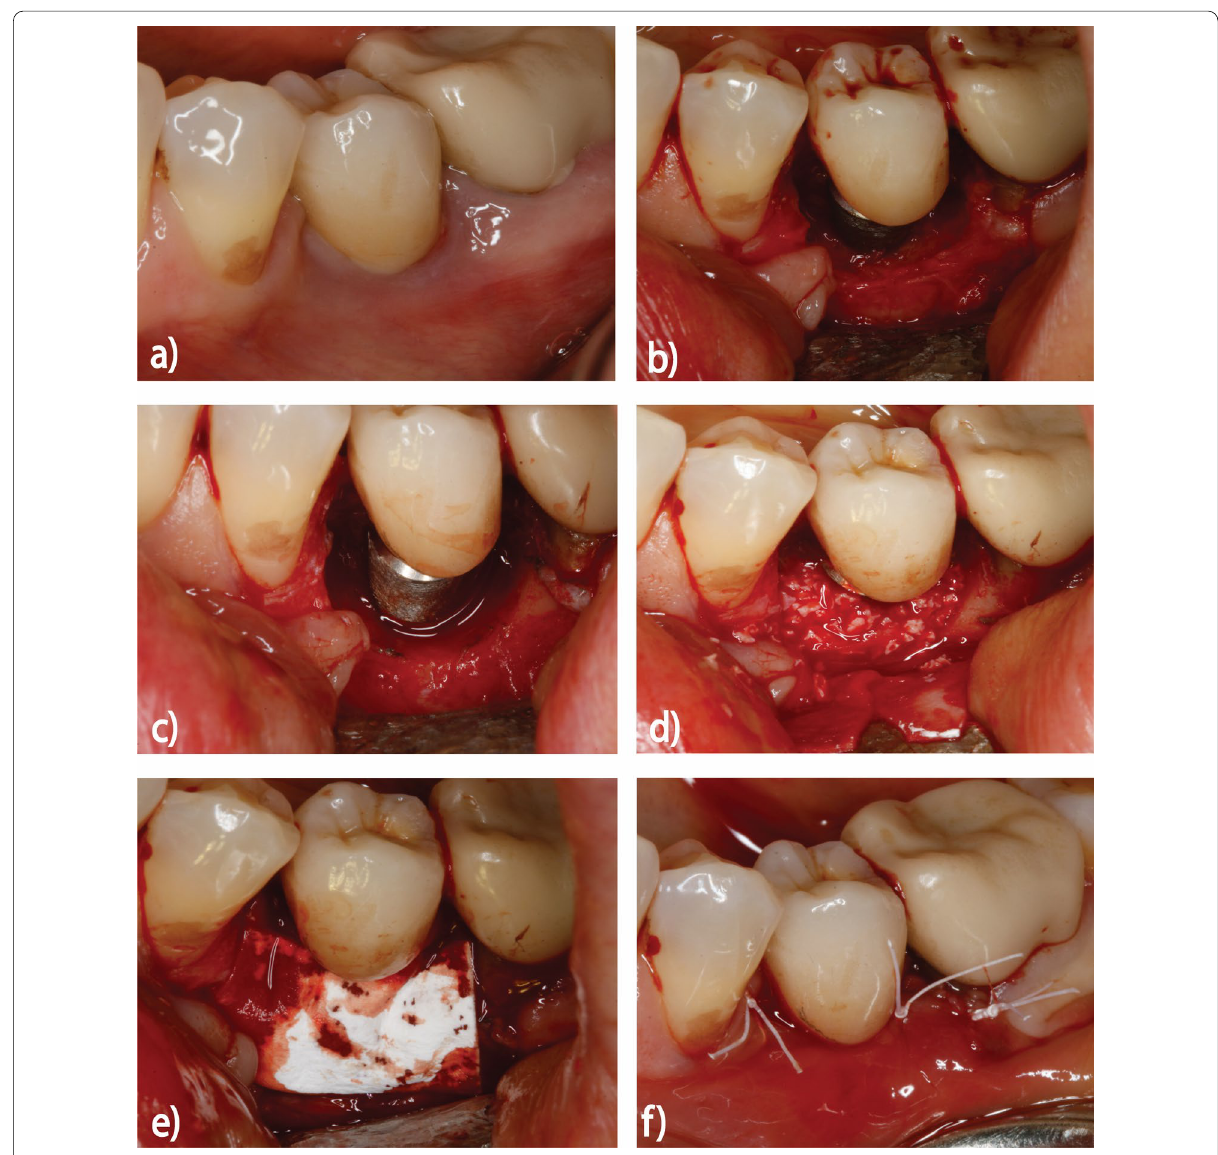
Fig. 1 Schematic diagram showing the protocol for peri‑implantitis combined surgical therapy: a initial situation before surgical therapy, b full thickness mucoperiosteal flaps raised at vestibular and oral aspects, c removal of granulation tissue and implant surface decontamination, d , e intrabony defect compartments were homogeneously filled using a natural bone mineral and covered with a native collagen membrane and f mucoperiosteal flaps were repositioned and adapted using non‑resorbable double